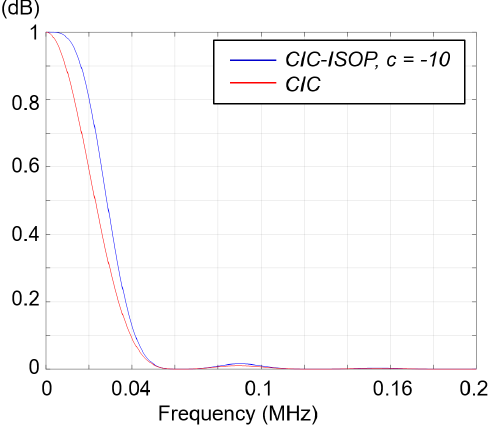
Figure 6. Frequency response. Only CIC filter vs. CIC-ISOP combination filter.